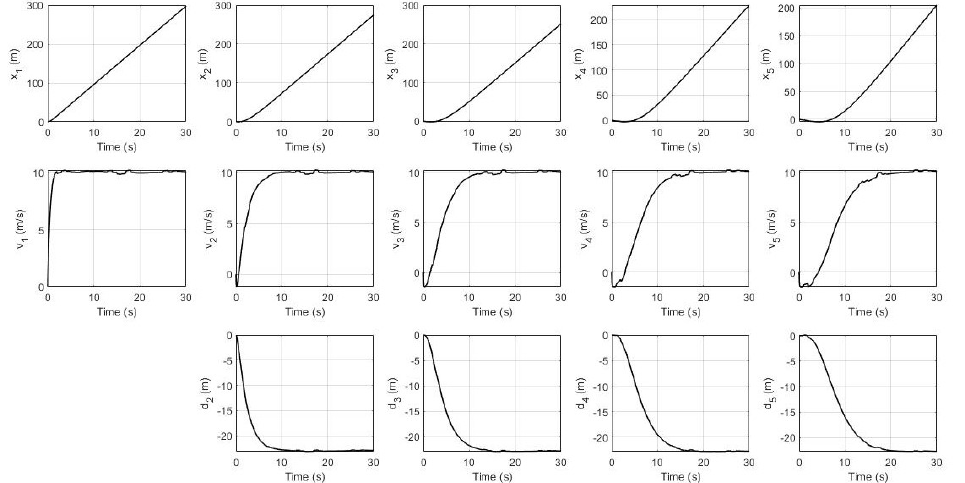
Figure 3. System’s response without